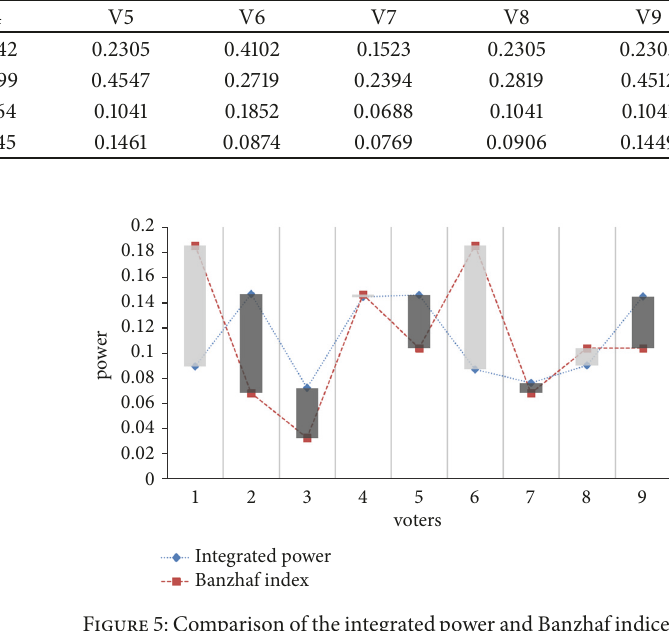
Figure 4: The social network in a voting group. The node V 𝑖 repre- sentsvoter 𝑖 , the node’ weightrepresents the knowledge professional level 𝑘 𝑖 , and the weighted edge represents the relationship closeness ( 𝑚 𝑖𝑗 ) among voters.